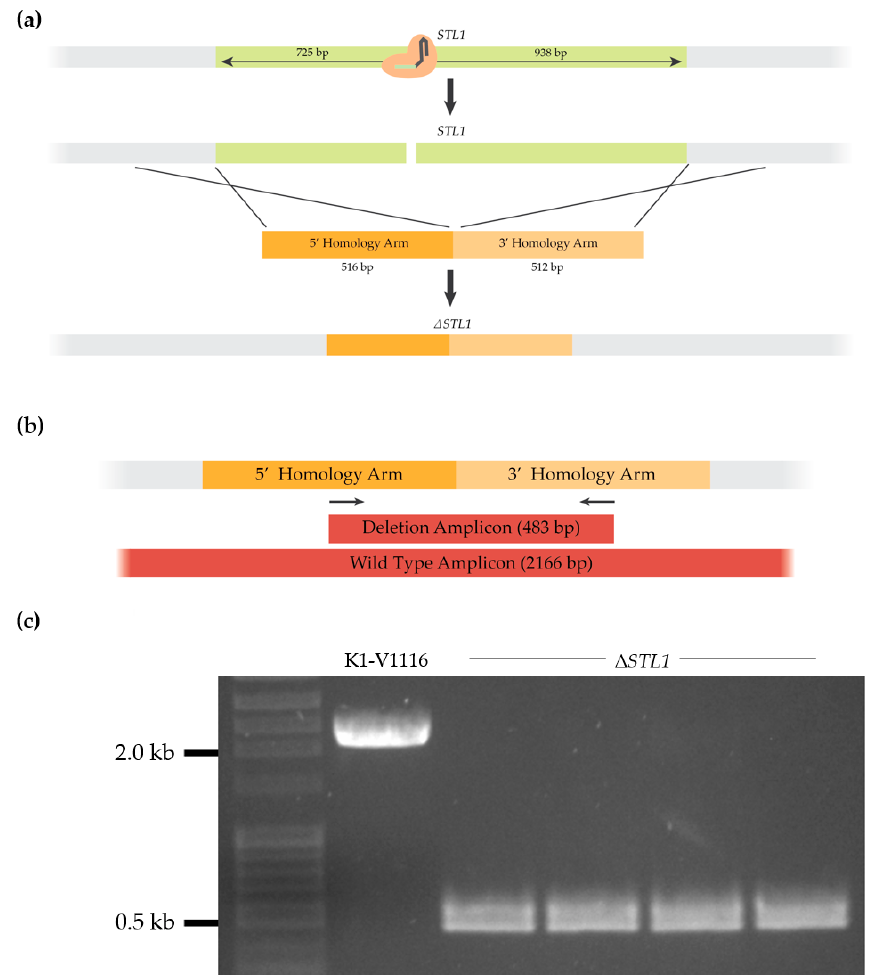
Figure 4. Schematic of STL1 and mechanism of CRISPR-Cas9 genome edit. CRISPR-Cas9 cleaves at the depicted location, resulting in homology directed repair with the ∆ STL1 donor DNA ( a ). PCR genotype scheme used to validate the integration ( b ). Gel image of STL1 genotype of K1-V1116 in lane 2 and K1-V1116 ∆ STL1 transformants in lanes 3 to 6 ( c ).